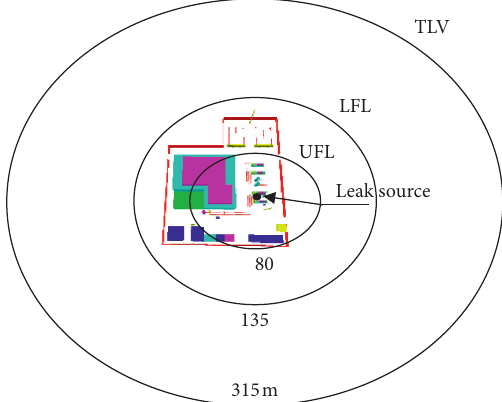
Figure 15: Hazardous zone of natural gas diffusion from a gas-storage cavern in salt